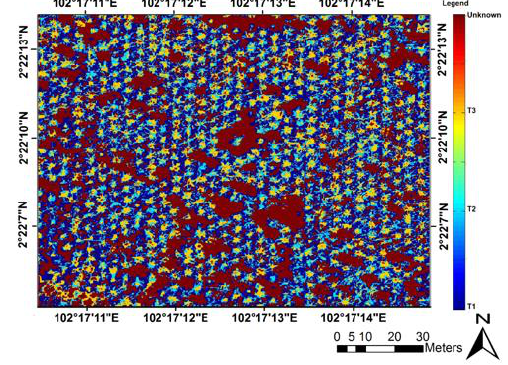
Figure 2. The UAV-SVM classified map.